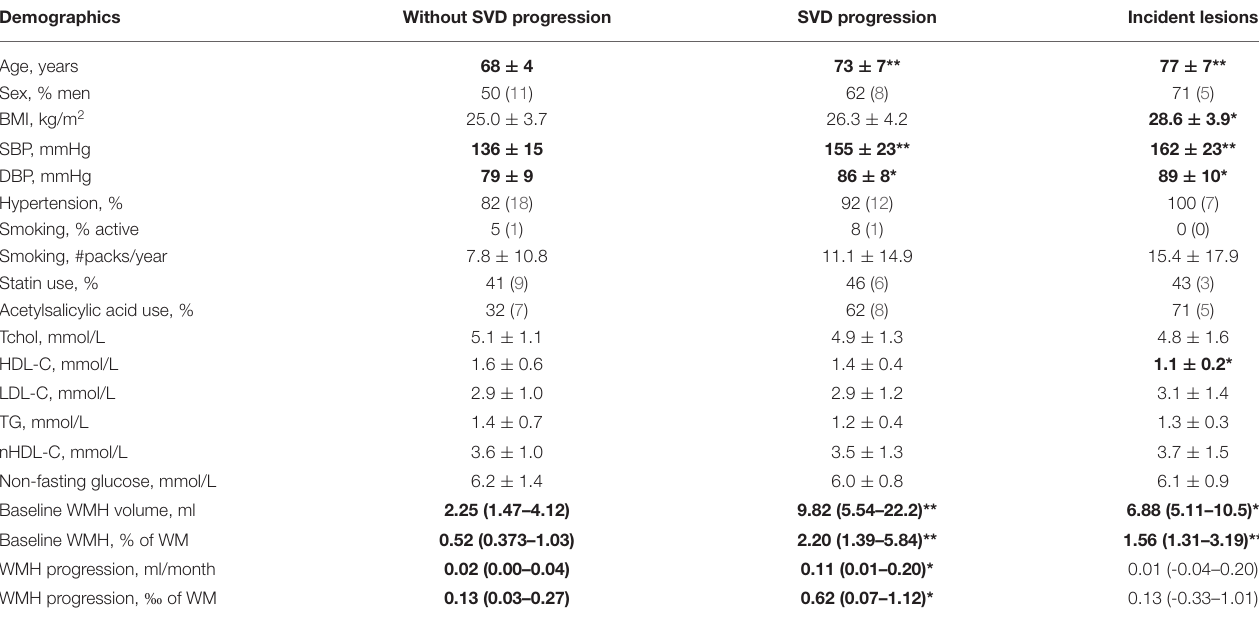
TABLE 1 | Participant